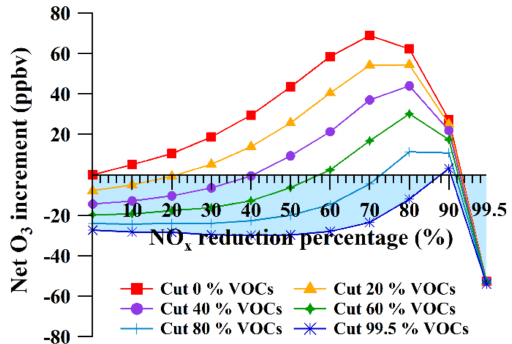
Figure 10. Net O 3 increment as a function of the reduction percent- ages of NO x and volatile organic compounds (VOCs). The high- lighted area represents zero O 3